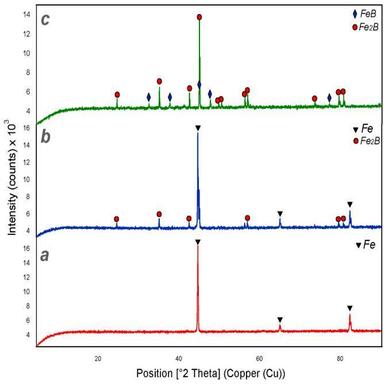
X-ray Diffraction (XRD) spectra of selected (1st, 6th, and 10th) layers on the n1 sample: a) Fe layer, b) 6. Layer, Fe+10 %B4C, c) 10. Layer, Fe+20 %B4C.